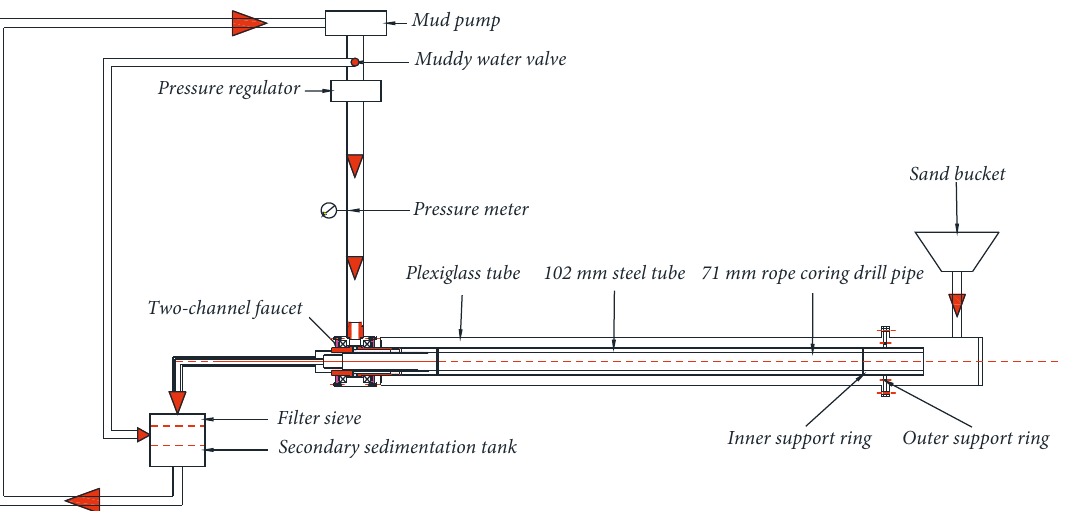
Figure 5: Schematic of the experimental system used to investigate cuttings-carrying during reverse circulation drilling with dual concentric